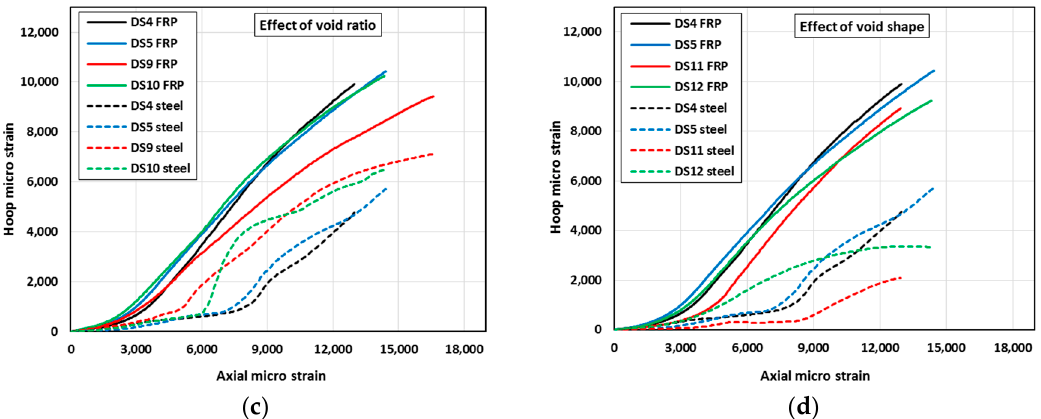
Figure 8. Axial strain vs. hoop strain: ( a ) Effect of concrete material at 1 and 2-FRP layer, ( b ) effect of steel tube thickness, ( c ) effect of void ratio, and ( d ) effect of void shape.